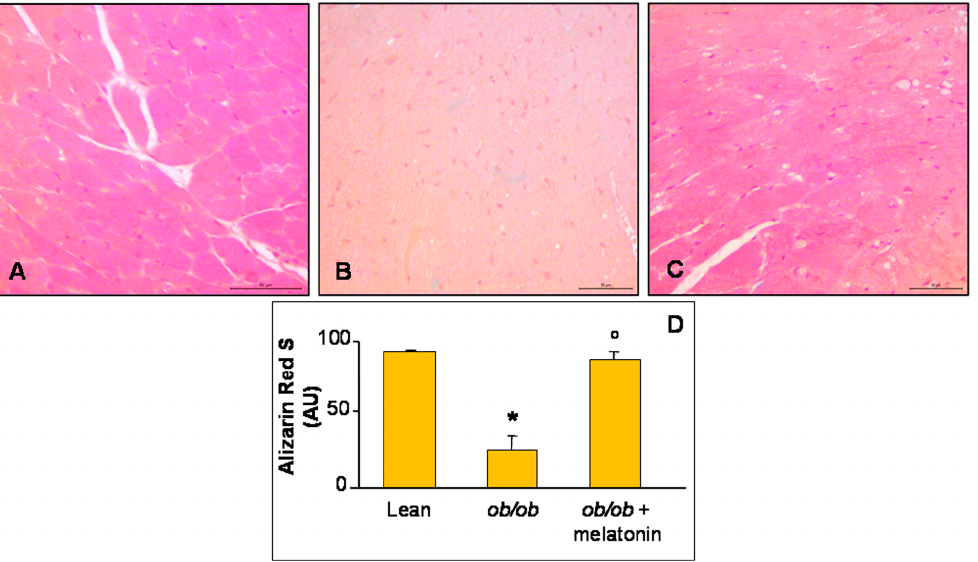
Figure 2. Alizarin Red S staining evaluation. Photomicrographs showing Ca 2+ accumulation in ventricular cardiomyocytes of lean mice treated and not treated with melatonin ( A ), ob / ob mice ( B ) and ob / ob mice treated with melatonin ( C ). Lean mice treated or not with melatonin displayed similar “normal” cardiomyocytes Ca 2+ accumulation data, so they are defined generically as “lean” mice. Note a bright orange to red Ca 2+ salts presence in lean mice, whereas a decreased accumulation in ob / ob mice and a significant recovery after melatonin treatment. Alizarin Red S staining. Scale Bar = 50 µm. The graph ( D ) summarize the quantitative analysis of Alizarin Red staining. * p ≤ 0.05 significant vs. lean mice; ° p ≤ 0.05 significant vs. ob / ob mice.